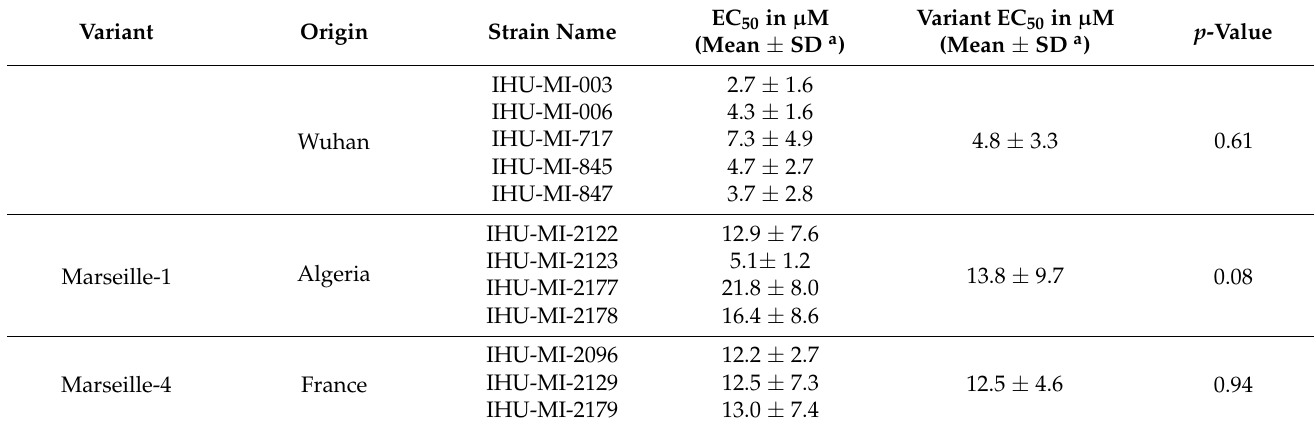
Table 3. In vitro susceptibility of different clinically isolated SARS-CoV-2 variants of concern or interest to